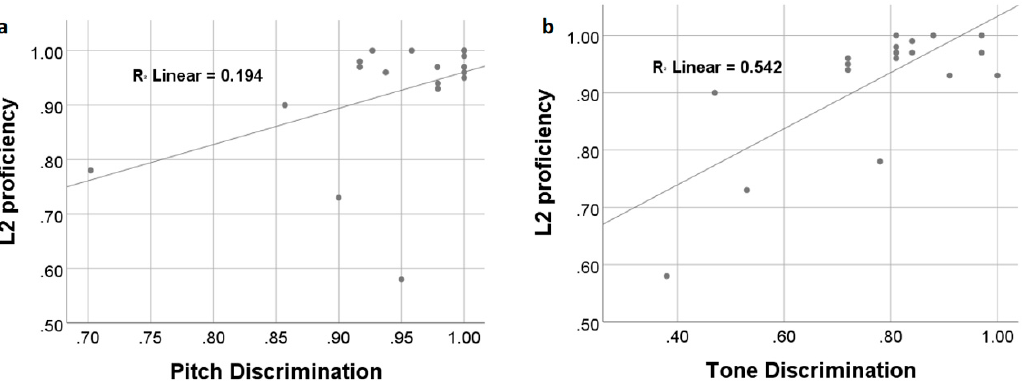
Figure 2. Participants’ L2 vocabulary learning performance was significantly and positively correlated with non-linguistic pitch ( a ) and linguistic tone ( b ) discrimination abilities.